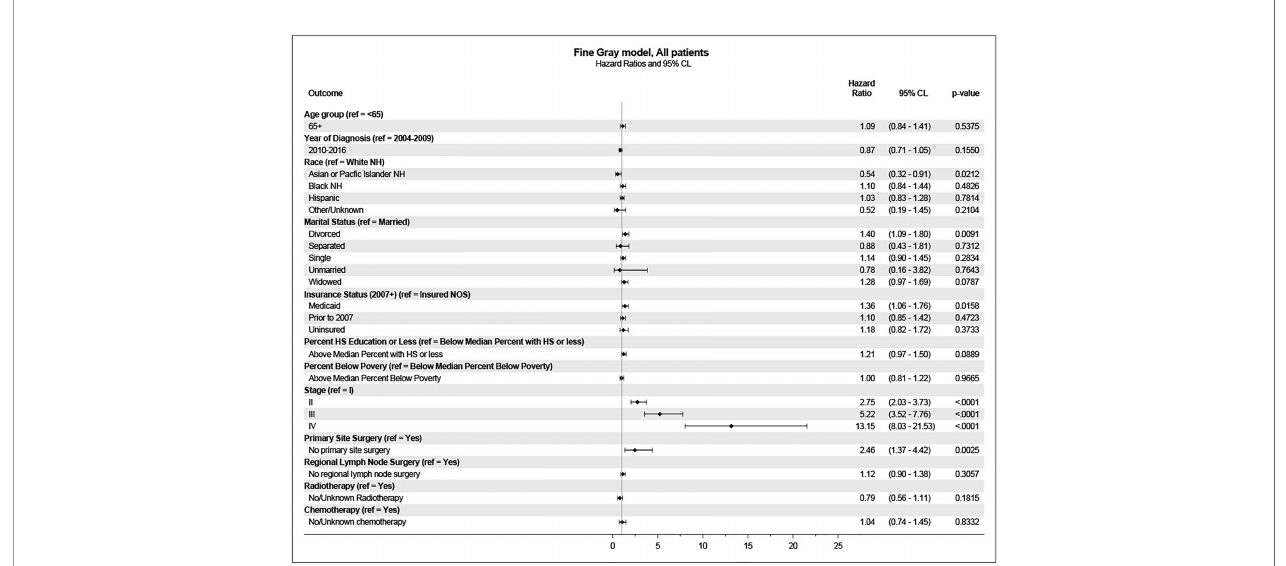
FIGURE 3 | Multivariate analysis for penile cancer survival (Fine-Gray model).